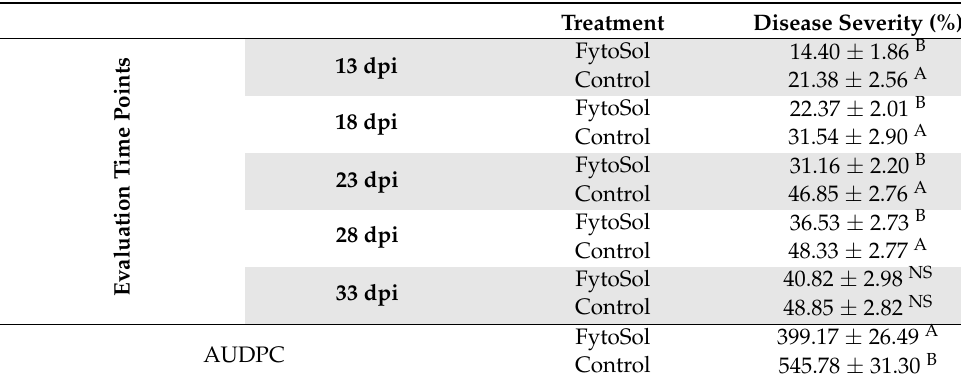
Table 1. The effects of FytoSol on Alternaria solani disease severity and progress on the tomato. Disease symptoms were evaluated using a 0–5 disease severity scale at five-time points (13, 18, 23, 28, and 33 dpi). The AUDPC value measures the quantitative severity of the disease from 13 to 33 dpi